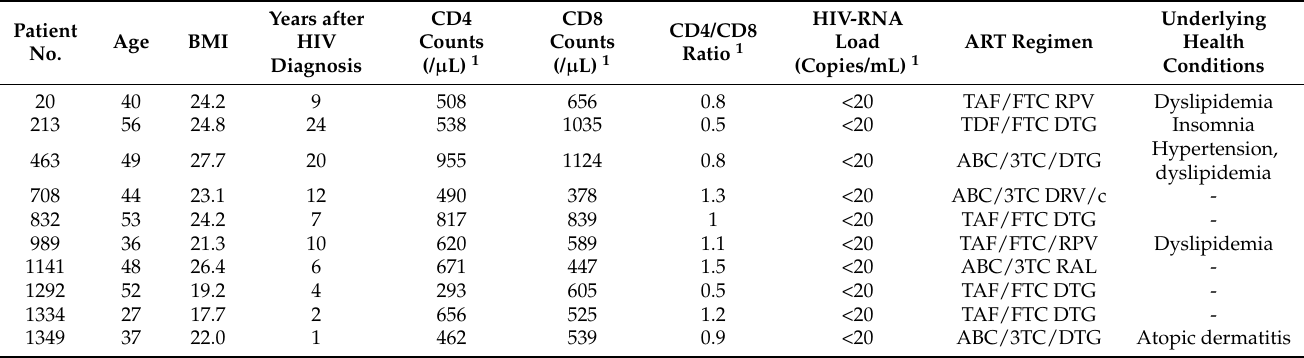
Table 2. Basic characteristics of HIV patients with hepatitis A.